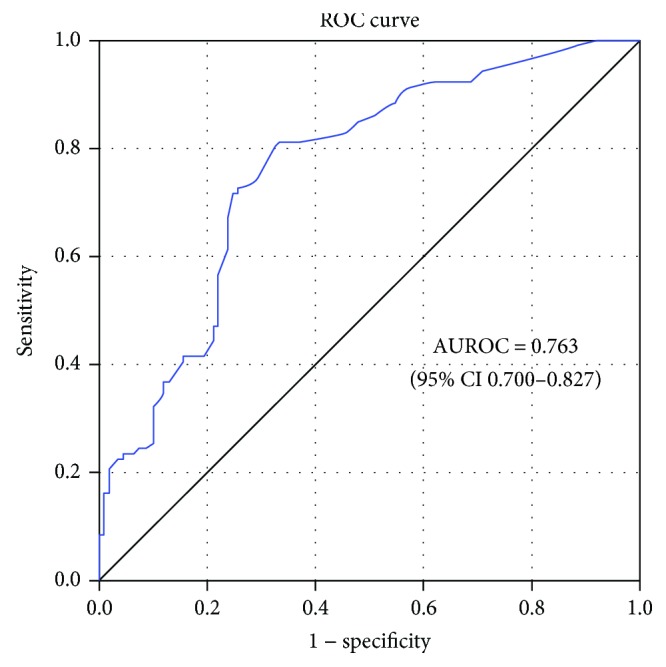
ROC curves of the predictive model and its respective AUROC (95% CIs). The blue curve is the ROC curve for the predictive model. Binary logistic regression was used to fit the model, and the ROC curve was used to evaluate the efficiency of prediction. Area under the ROC curve (AUROC) > 0.75 was considered good predictive ability.